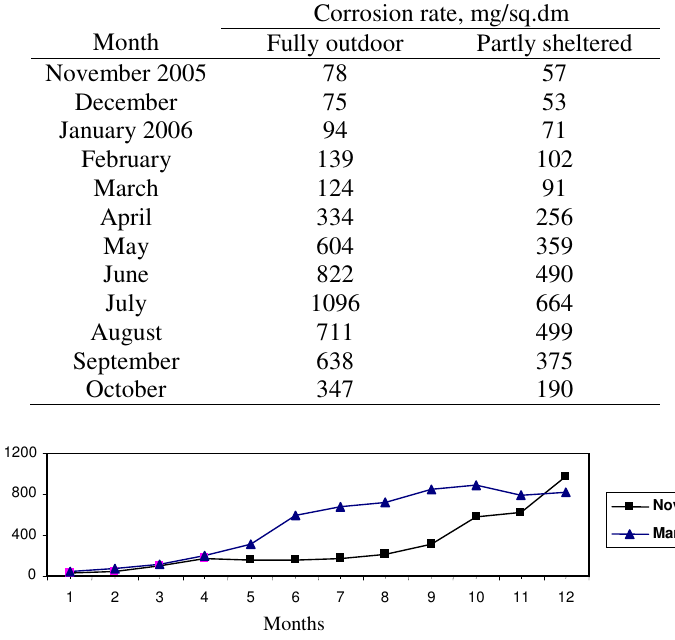
Figure 4. Progressive corrosion rate (CR) of zinc under outdoor exposure at an urban atmosphere.